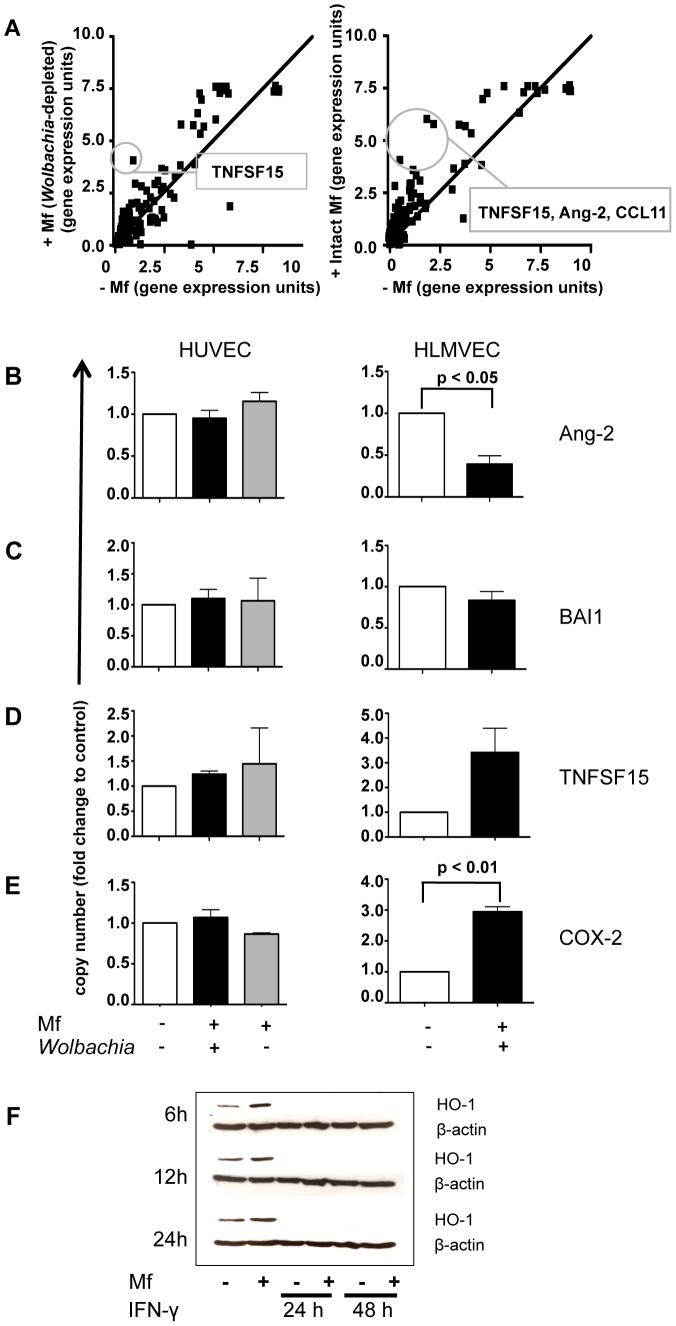
Limited alterations in the gene expression of angiogenic mediators in vascular EC in the presence of live B. malayi Mf.HUVEC or HLMVEC were cultured with or without live untreated B. malayi Mf or Wolbachia-depleted Mf for 24 hours prior to isolation of total EC RNA. An oligo microarray was used to analyse mRNA expression of various angiogenesis mediators (a). mRNA expression was compared between HUVEC in the absence of Mf vs. presence of intact Mf and HUVEC in the absence of Mf vs. presence of Wolbachia-depleted Mf. HUVEC and HLMVEC mRNA expression of (b) Ang-2, (c) BAI-1, (d) TNFSF15 and (e) COX-2 was also analysed by real time qRT-PCR. Data are shown as the mean of two independent experiments (oligo microarray) or mean and standard deviation of three independent experiments (qRT-PCR). Students t-test was used to analyse statistical significance. (f) HO-1 protein expression in HLMVEC is enhanced by live Mf presence. HLMVEC were left unstimulated or were stimulated with IFN-γ for 24 or 48 hours, prior to co-culture with live Mf for a further 6, 12 or 24 hours. HLMVEC cells were lysed and the cell lysate was analysed for protein levels of HO-1 by western blotting.